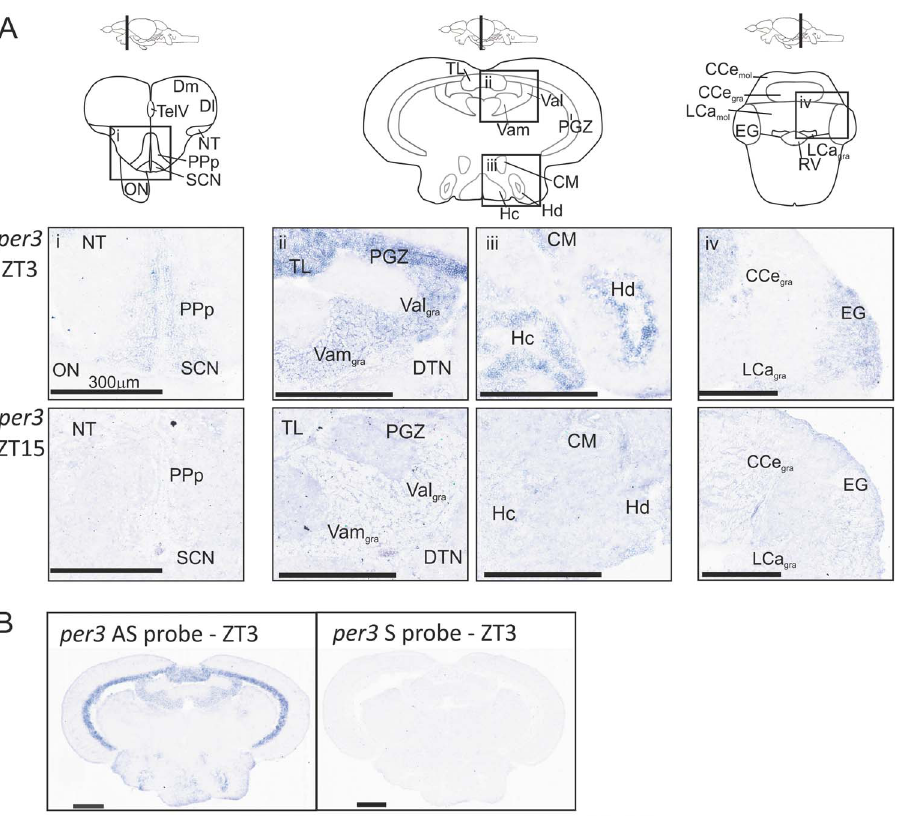
Figure 3. Regional per3 expression in the adult zebrafish brain. Adult zebrafish were kept on a 14:10LD cycle and brains were collected at ZT3 and ZT15. In situ hybridization was performed to show expression of per3 mRNA. A) Schematics of the brain containing the diencephalon, mesencephalon and rhombencephalon are shown. At ZT3 there is expression of per3 in the i) PPp and SCN, ii) PGZ, TL, Val gra and Vam gra , iii) CM, Hc and Hd, iv) EG, CCe gra , and LCa gra . At ZT15 there is either low or undetectable levels of per3 in these same regions. B) The antisense (AS) probe shows the per3 expression and the sense (S) control shows the background signal.